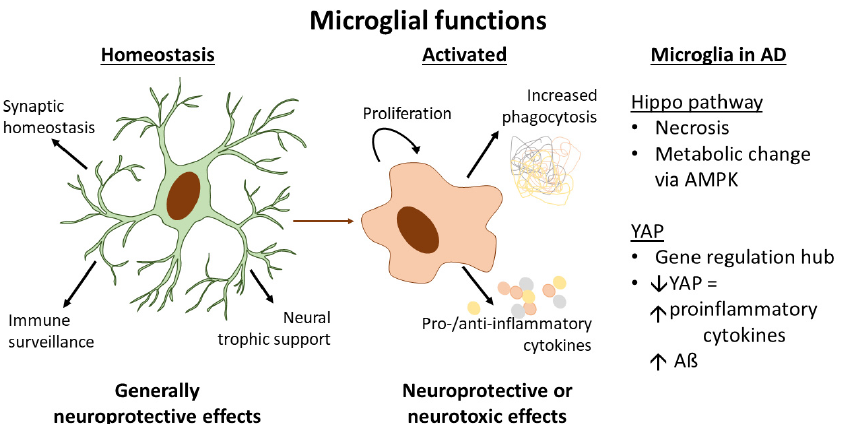
Figure 1. Functions associated with microglia in the homeostatic and activated states, including roles currently known and ascribed to microglial Hippo pathway components/YAP in Alzheimer’s disease (detailed in Section 4). During homeostasis, microglia perform functions in the CNS to support neurons and to surveil for pathogens or other debris. Once activated by a number of possible stimuli, microglia change gene expression and function to increase their phagocytic ability, and to resolve infection/damage by releasing pro- and/or anti-inflammatory cytokines. These activated functions may result in resolution of infection/damage and thus neuroprotection or, for example, in neurodegenerative diseases, result in continued inflammation and subsequent neurotoxic effects. Current evidence suggests that the Hippo pathway and YAP have important roles in microglia in the pathogenesis of AD. AD, Alzheimer’s disease; AMPK, AMP-activated kinase; YAP, Yes-associated protein; A β , amyloid